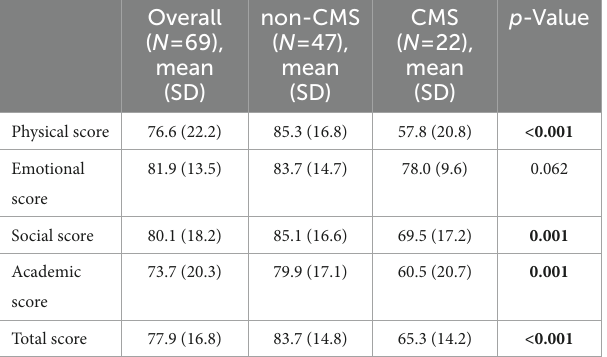
TABLE 3 comparison of QOL between CMS and non-CMS patients. Overall ( N =